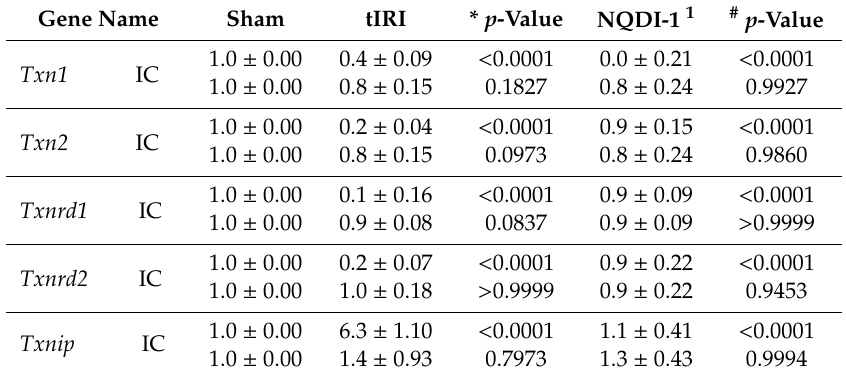
Table 2. Relative mRNA expression of the Trx system genes calculated by the 2 ‐ΔΔ CT formula.